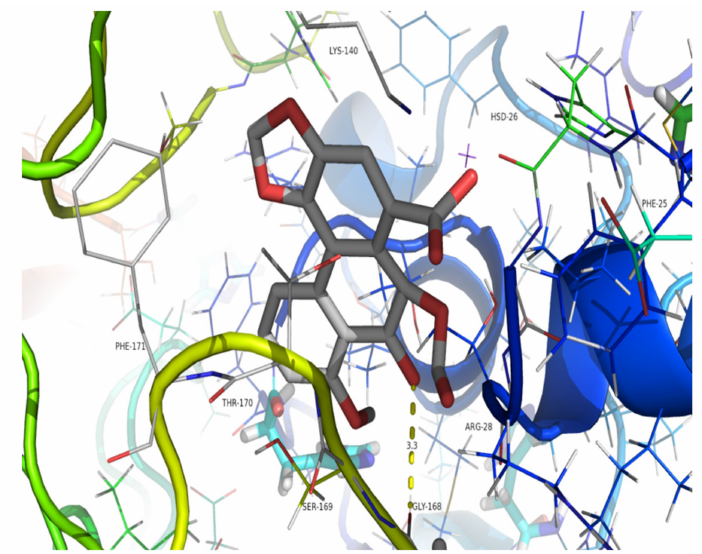
Figure 5. Binding pose of compound 9 docked into the protein 4NOG. The yellow dotted line indicates a hydrogen bond between compound 9 and